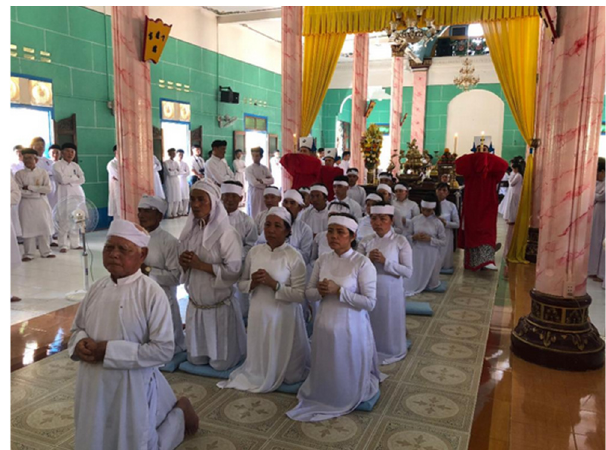
Figure 6. Second-day funeral ritual, the dance-like offering (in red), Tây Ninh, 2 July 2018 (© Shao Zhu Shuai).